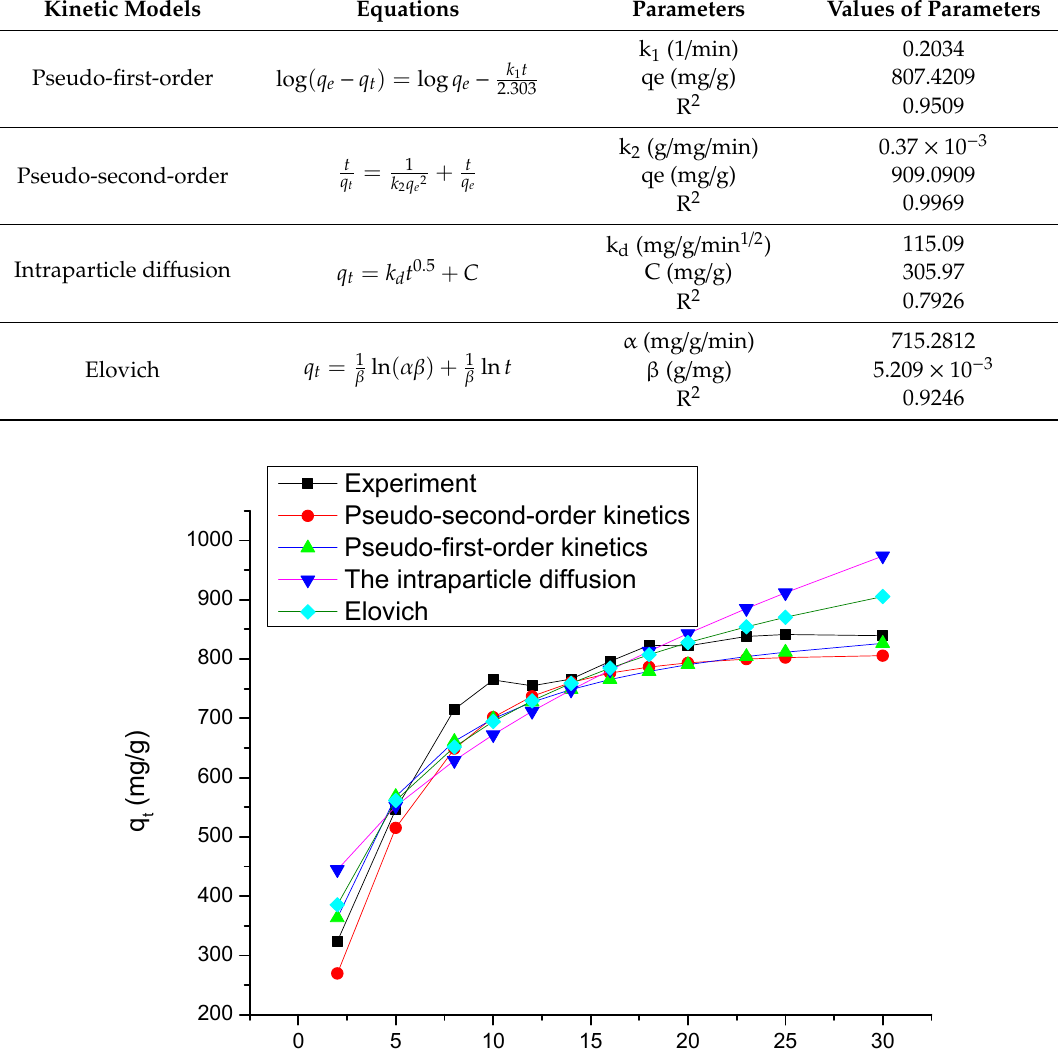
Table 8. Kinetic parameters for the removal of EV on Mn-doped Fe / rGO.